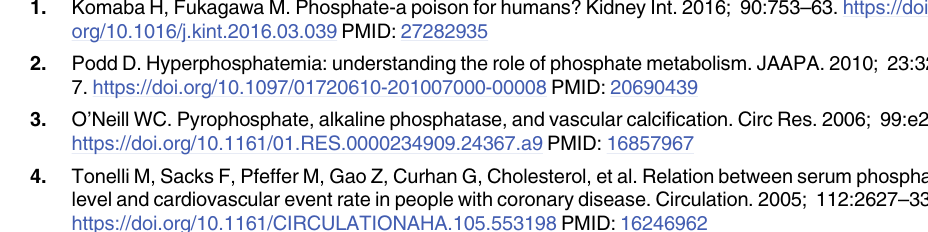
S1 Fig. The change in the average standardized absolute mean difference before and after inverse probability weighting